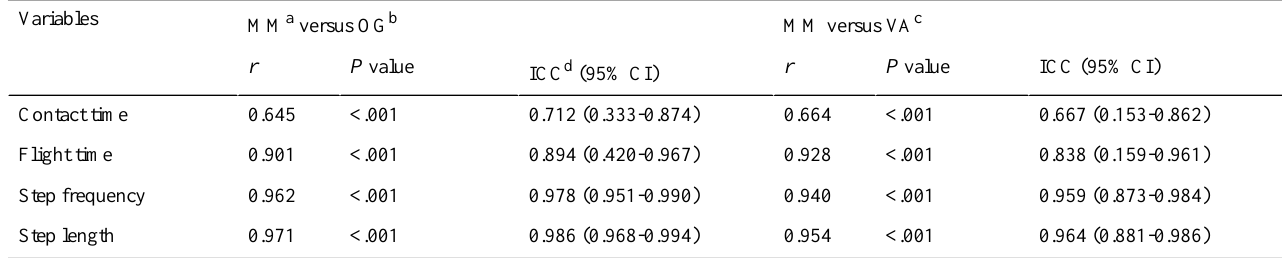
Table 3. Pearson correlation analysis and intraclass correlation coefficients between spatiotemporal parameters obtained from the Kinect system with the MotionMetrix software and those obtained from two different systems (ie, OptoGait and high-speed video analysis) during running at a comfortable